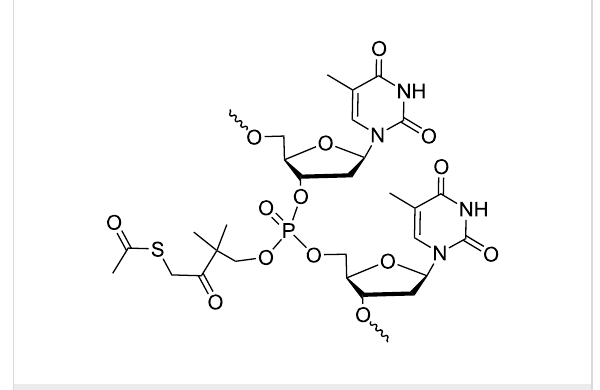
Figure 2: Oligothymidylates containing esterase and thermo-labile (4-acetylthio-2,2-dimethyl-3-oxobutyl) phosphate protecting groups